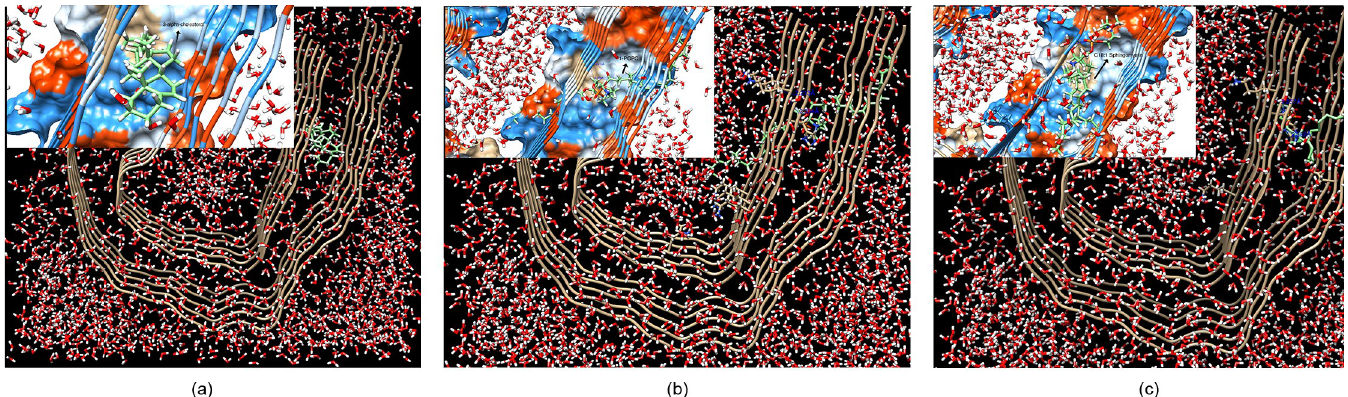
Fig 13. Ligand (AM1-BCC optimized structure) embedded in PHF-Tau protofilament (tail side); RMSD = 0. Hydrophobicity surface is shown. Solvent used is water. Inset shows the preferred configuration of the the ligand: (a) cholesterol; (b) 1-palmitoyl-2-oleoyl-sn-glycero-3-phosphocholine; and (c) C18:1 sphingomyelin and their interactions with the